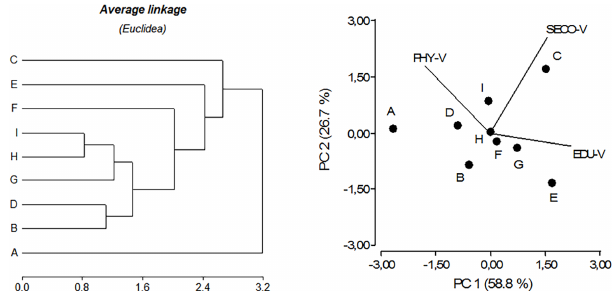
Figure 8. (a) Cluster analysis and (b) principal components analysis for different dimensions of vulnerability by neighborhood: PHY- V (physical vulnerability), SECO-V (socioeconomic vulnerability) and EDU-V (educational vulnerability).